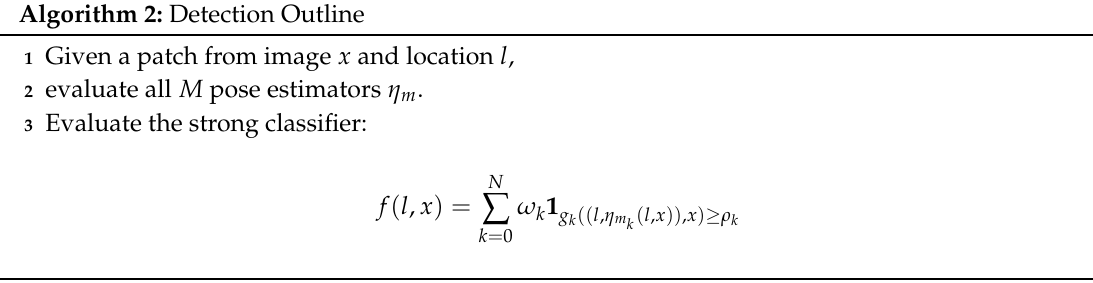
Algorithm 2: Detection